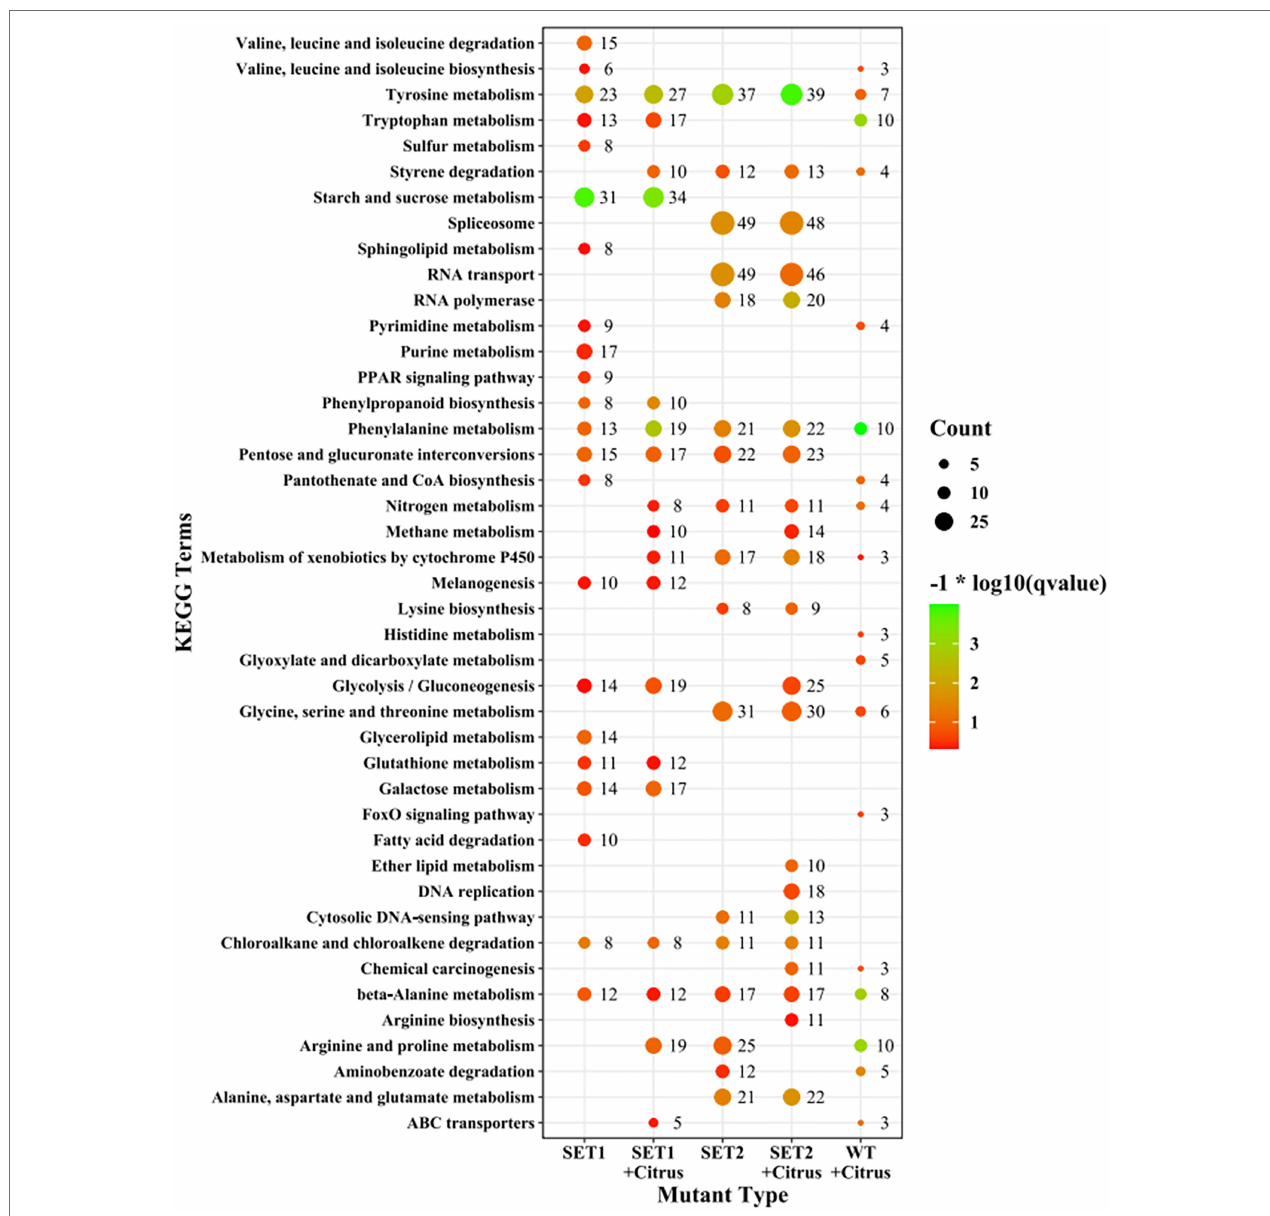
FIGURE 8 | KEGG enrichment analysis of Δ AaSet1 and Δ